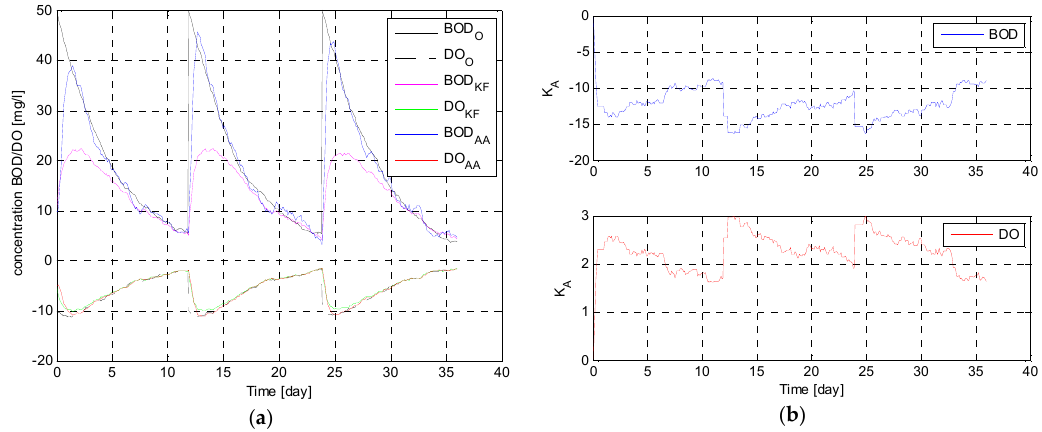
Figure 8. Distribution of BOD and DO signals ( a ) and adaptive algorithm gain coefficients ( b ) for matrices W = [3, -2; -2, 1] and V = [0.1].